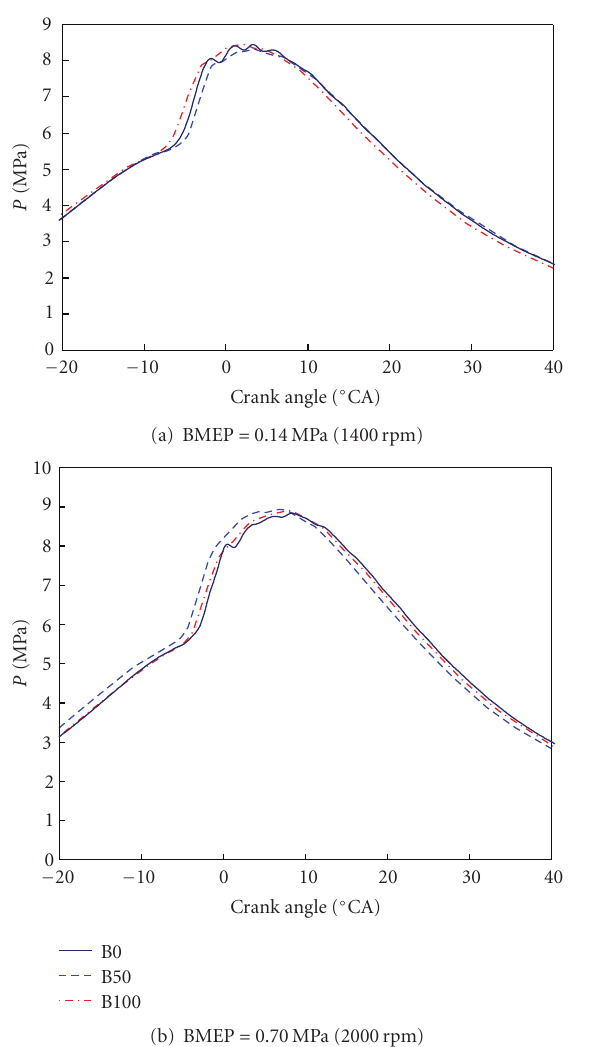
Figure 8: Diesel engine in-cylinder pressure when burning di ff erent fuels.